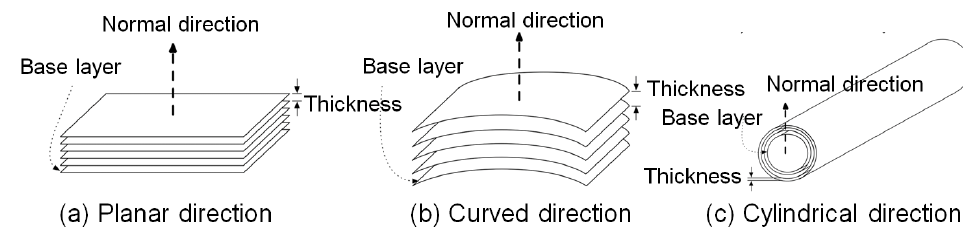
Figure 9. 2D operations of additive manufacturing.